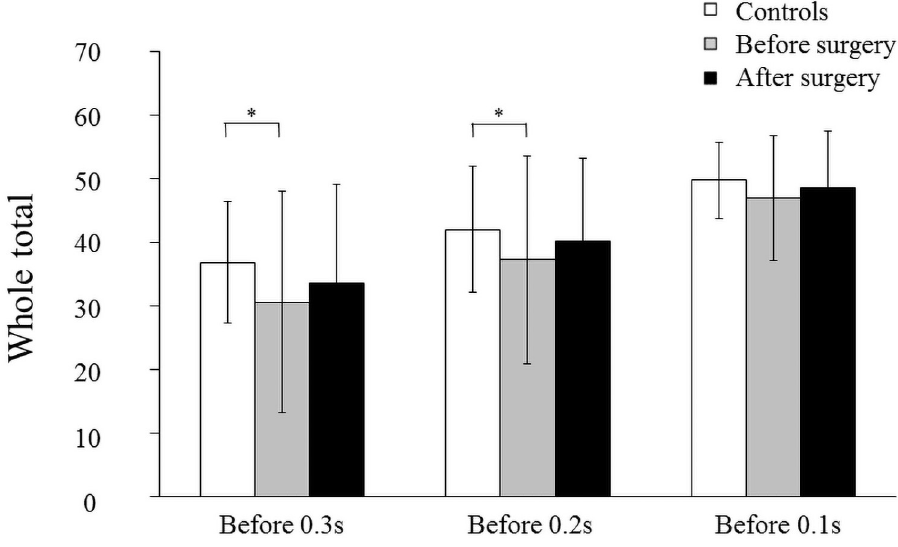
Fig 3. Total number of electrodes contact. Mean and standard deviation in the total number of electrodes of tongue- palatal contact (WT) in the controls, patients before surgery, and after surgery at 0.3, 0.2 and 0.1 seconds before complete tongue-palatal contact ( � : p < 0.05, �� : p <